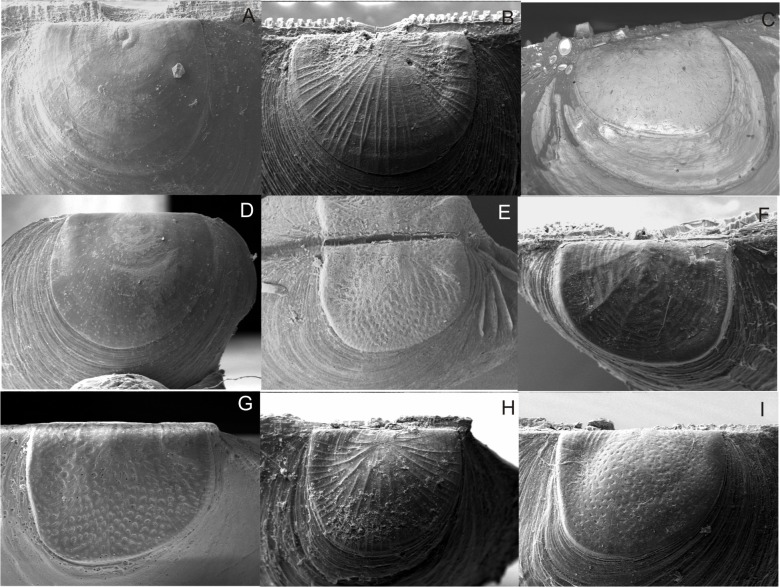
Philobryid prodissoconch morphology.For species identifications refer to Fig. 2.